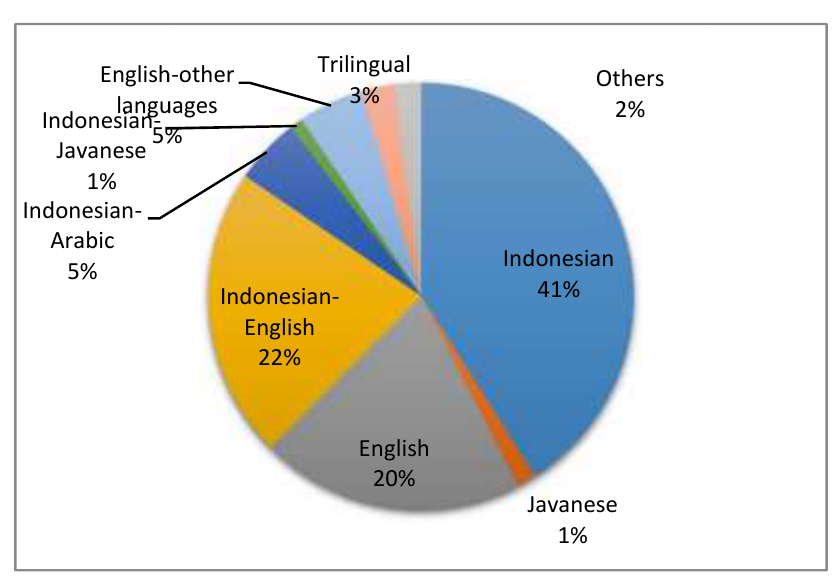
Figure 1. Visible Languages in Sidoarjo LL